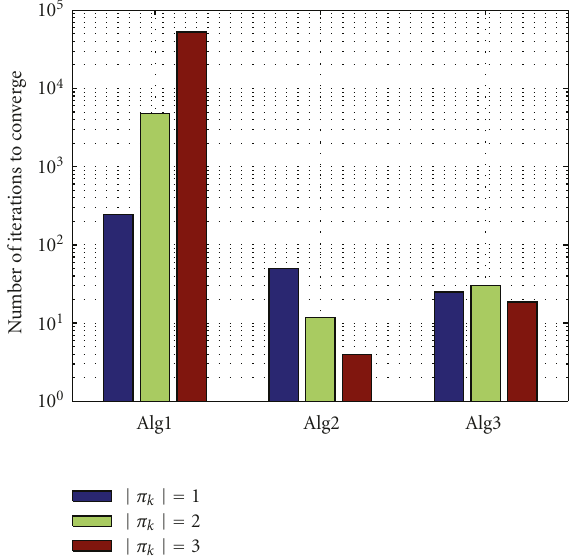
Figure 12: Comparison of total number of iterations for di ff erent algorithms and π k